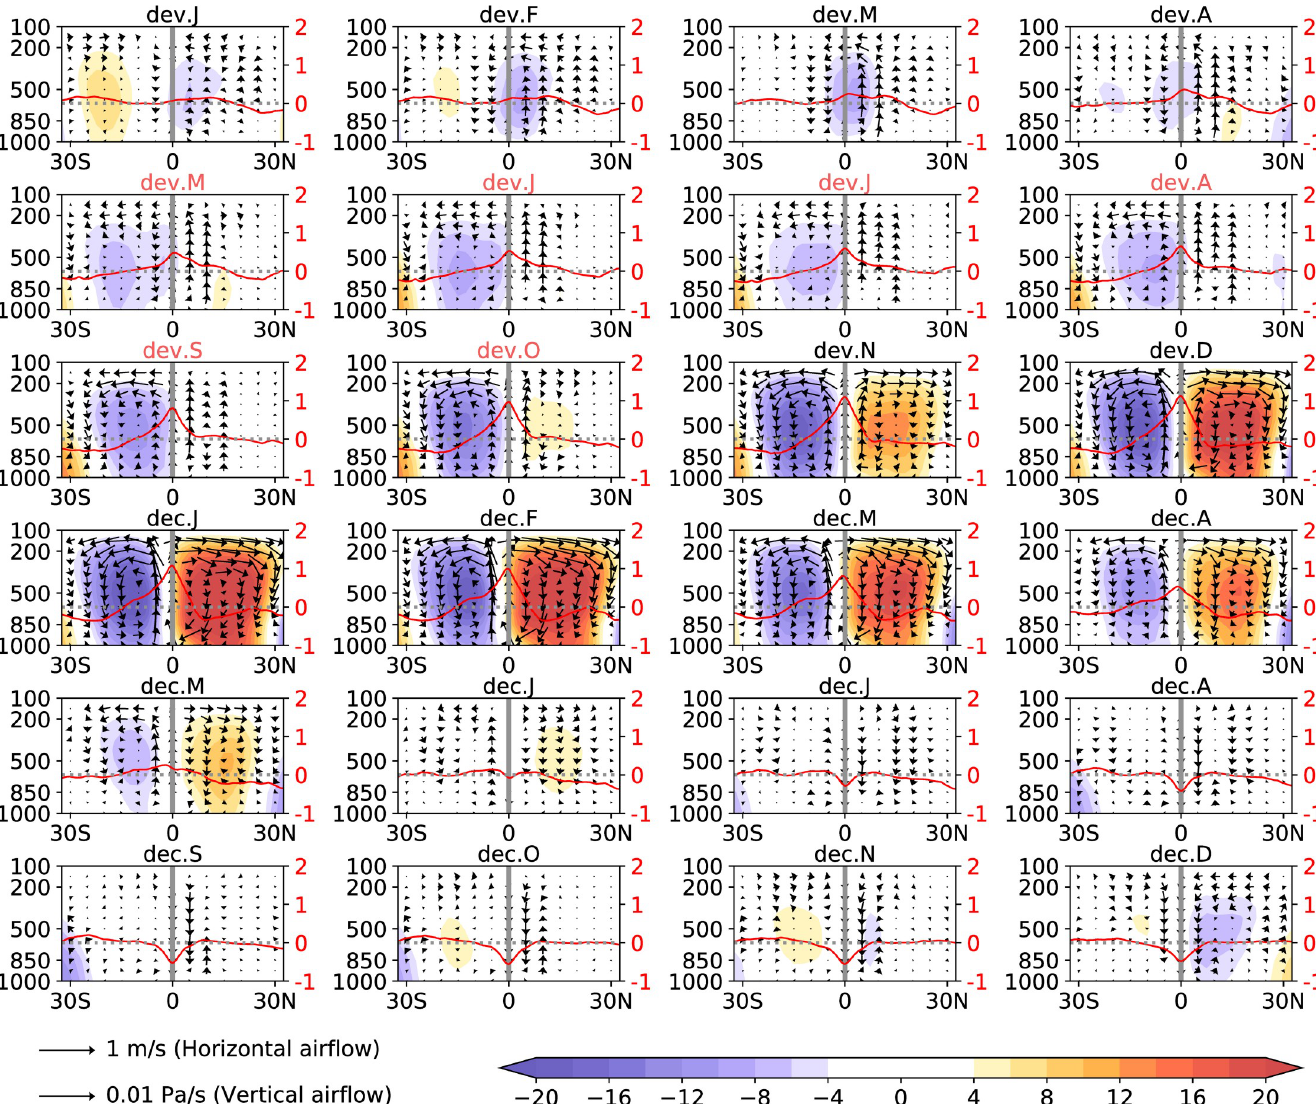
Fig 2. Composite MCA in the Central Pacific (140˚E–140˚W) during El Ni ñ o years. The shading indicates the average zonal MSF of eight El Ni ñ o events (unit: 10 10 kg s -1 ). The purple area indicates counter-clockwise movement, and the red or yellow areas indicate clockwise movements. The arrow indicates the magnitude and direction of the wind speed (unit of horizontal airflow: m s -1 ; unit of vertical airflow: 10 − 2 Pa s -1 ). The red line indicates the zonal average (140˚E–140˚W) SSTA (unit: ˚C). The grey line indicates the equator. Title dev. J-D indicates January–December of the El Ni ñ o developing year; dec. J-D indicates January–December of the El Ni ñ o decaying year. MCA asymmetry mainly occurs during May–October of the El Ni ñ o developing year, which are marked in red.